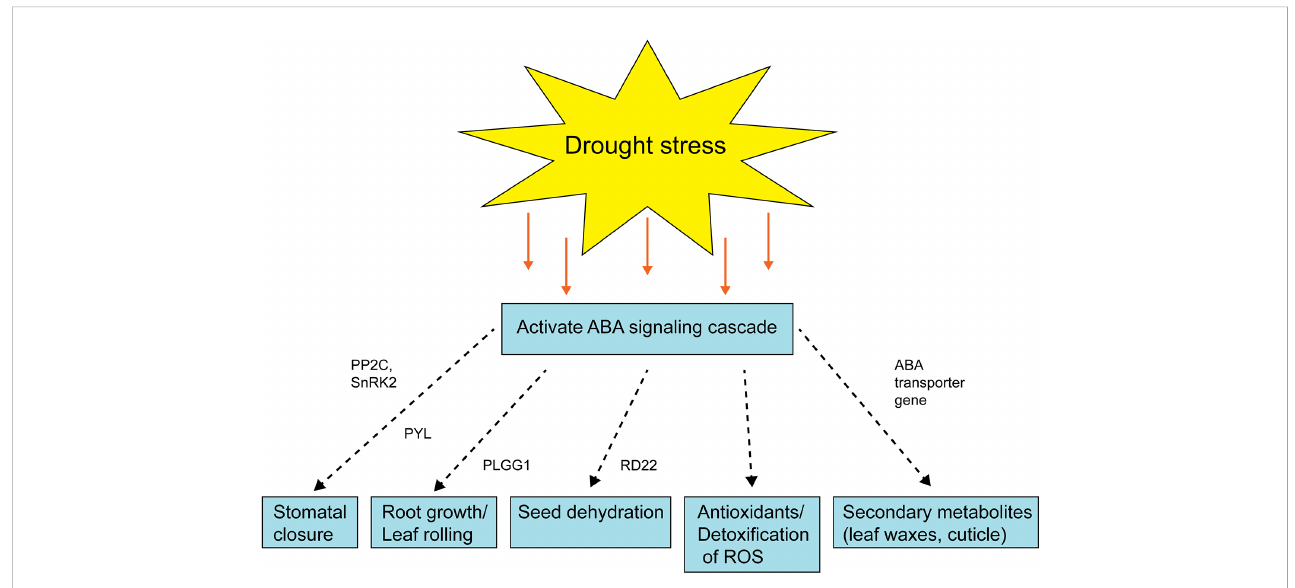
FIGURE 4 Schematic diagram showing the role of ABA signaling after drought stress activation. The dashed arrow represents the multiple steps are involved and green box represents the enzyme/gene for that process. PYL, pyrabactin resistance (PYR)-like; PP2C, protein phosphatases ; SnRK2s, SNF1-related protein kinase; PLGG1, plastidal glycolate/glycerate translocator 1 ; RD22, Responsive to dehydration 22